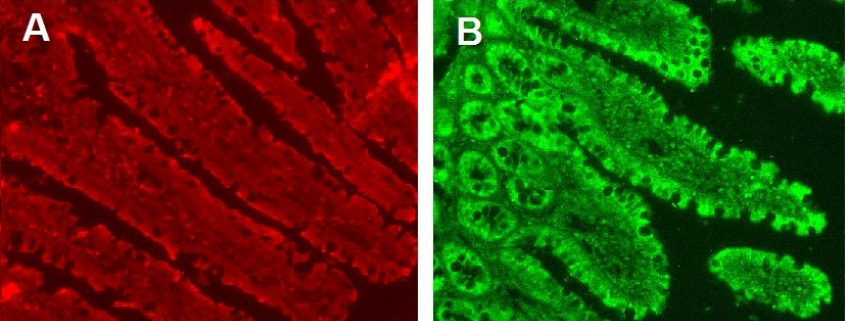
Figure 6. The results of the immunohistochemical analysis of transporters SGLT1 and GLUT2 in rat jejunal enterocytes. ( A ) SGLT1, ( B ) GLUT2. Since a quantitative assessment of the content of these transporters in the apical membrane of enterocytes did not reveal differences in type 2 diabetes and HFD control, images for each transporter are presented in one copy.